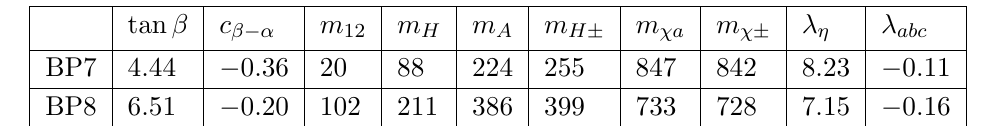
Figure 9 . Feynman diagrams contributing to the mono-Higgs production via the process pp ! (cid:31)(cid:31)h .